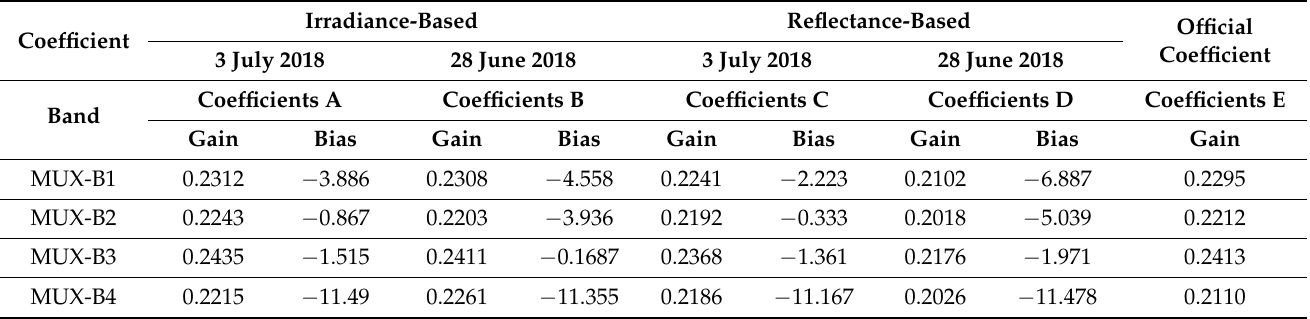
Table 5. Different radiometric calibration coefficients using the reflectance-based and irradiance-based